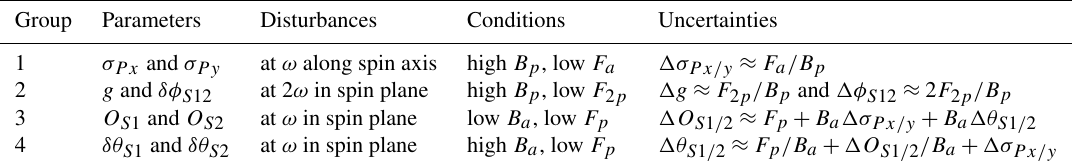
Table 2. Parameters and favorable